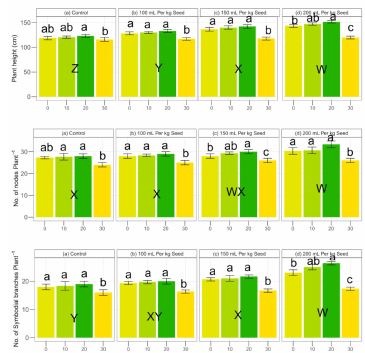
Figure 2. E ff ect of potassium humate on plant height, number of nodes and sympodial branches of cotton. Within the seed dressing application, the same lowercase letter (s) a, b, or c, indicates that the soil potassium humate application rates are not statistically di ff erent at p < 0.05. Among the seed dressings, the same uppercase letter (s) W, X, Y or Z, showed a non-significant e ff ect. Error bars represent the standard deviation of the mean (n = 3, three replications).